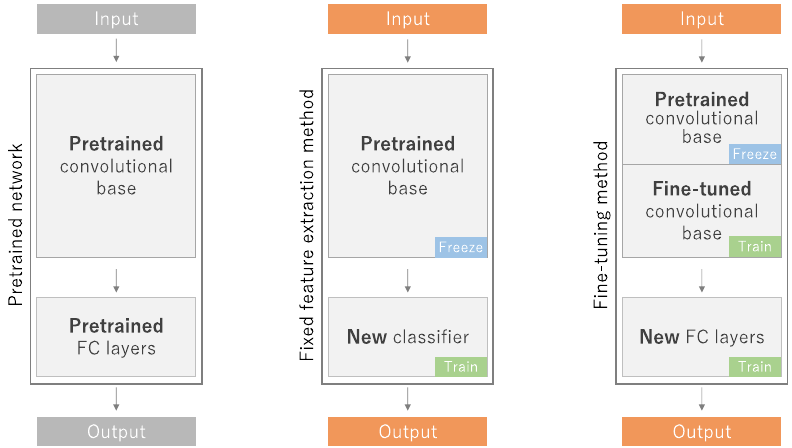
Fig. 10 Transfer learning is a common and effective strategy to train a network ona small dataset,where a network is pretrainedonanextremely large dataset, such as ImageNet, then reused and applied to the given task of interest. A fixed feature extraction method is a process to remove FC layers from a pretrained network and while maintaining the remaining network, which consists of a series of convolution and pooling layers, referred to as the convolutional base, as a fixed feature extractor. In this scenario, any machine learning classifier, such as random forests and